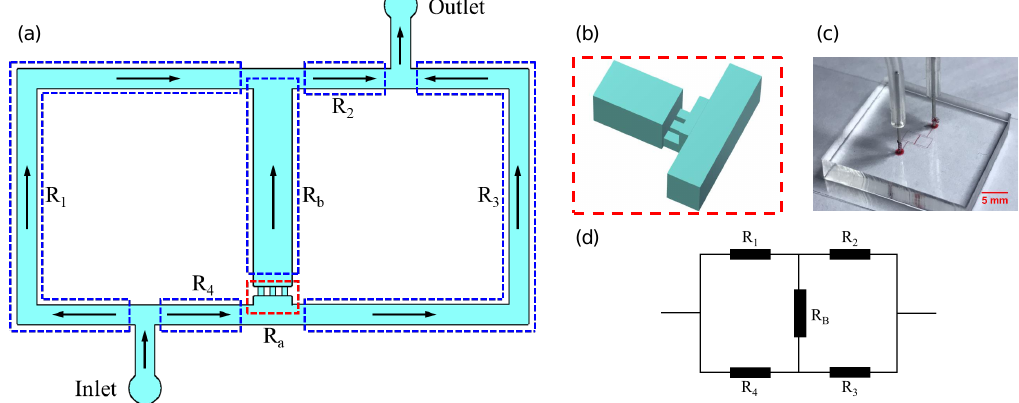
Figure 1. ( a ) Schematic of the Wheatstone bridge microchannel. The microchannel is divided into four segments with distinct flow resistances ( R 1 , R 2 , R 3 , R 4 ) by the inlet, outlet, and bridge microchannels. ( b ) Micropipette aspiration microchannels. ( c ) A picture of the device. ( d ) The equivalent circuit of the Wheatstone bridge